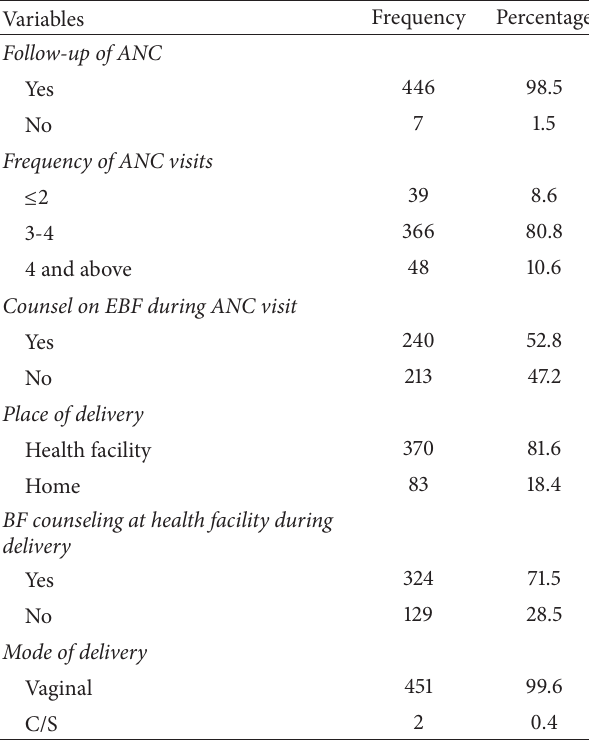
Table 3: Breastfeeding practices of the respondents ( 𝑛 = 453 ) in Debre Tabor town, Northwest Ethiopia,